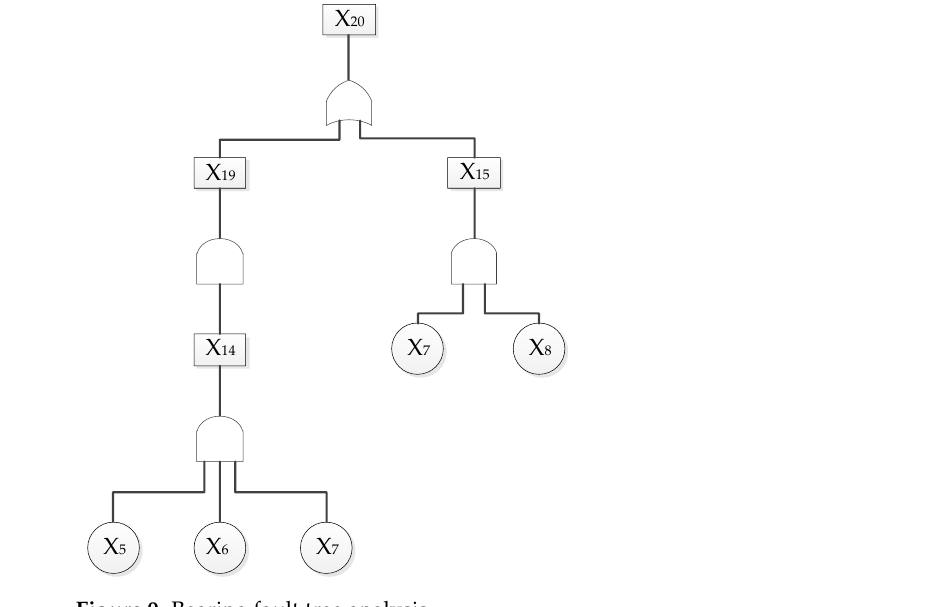
Figure 9. Bearing fault tree analysis.